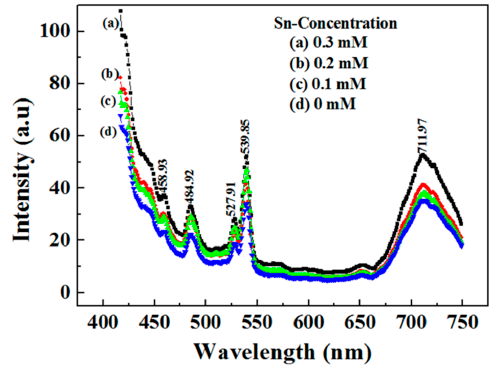
Figure 9. Photoluminescence spectrum of CdO films with different Sn concentrations.